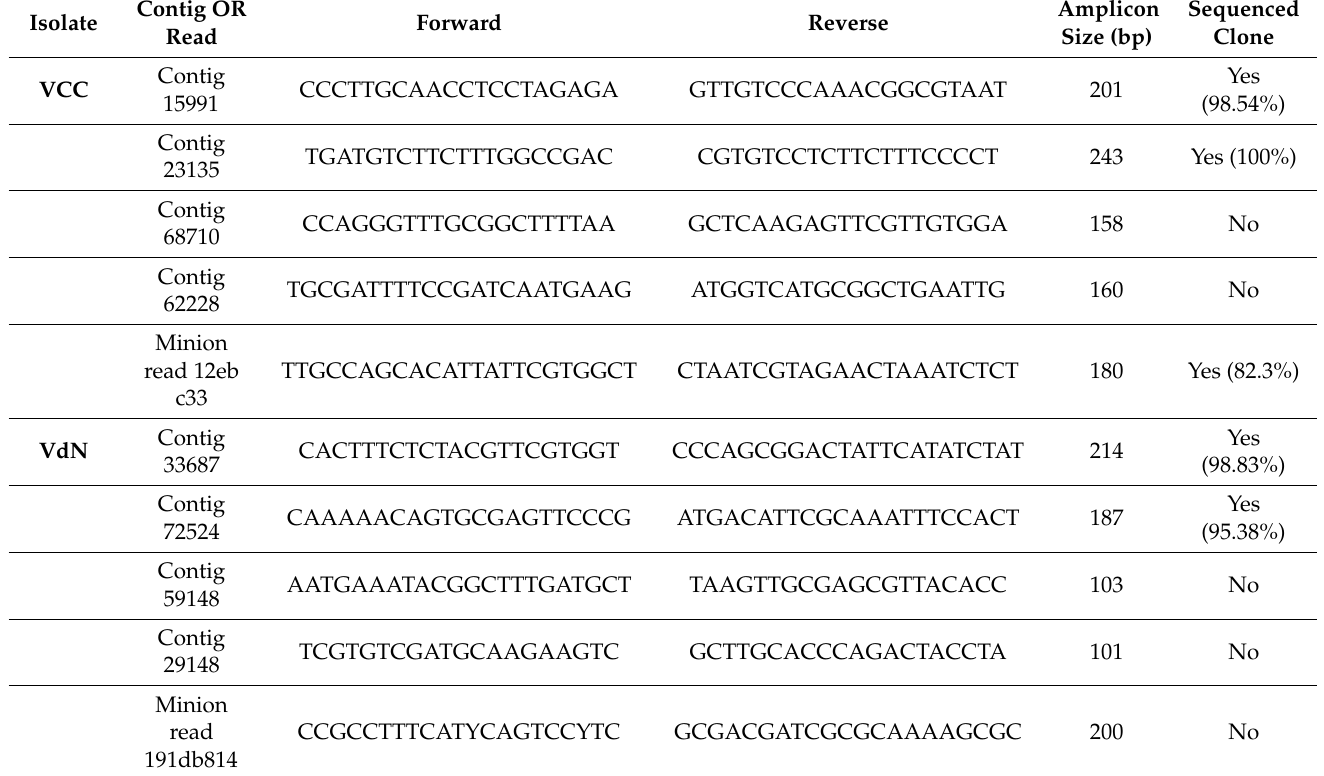
Table 1. List of primers designed in the selected contigs/reads obtained from VCC and VdN accessions, together with their amplicon size. The percentage of nt identity of the cloned and sequenced amplicons with the original sequences from libraries is reported in